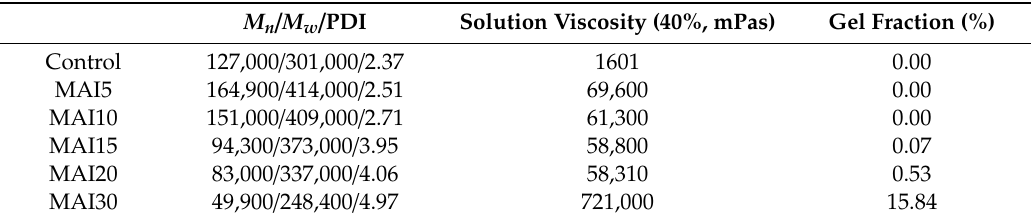
Table 3. Basic information on synthesized SPSAs.